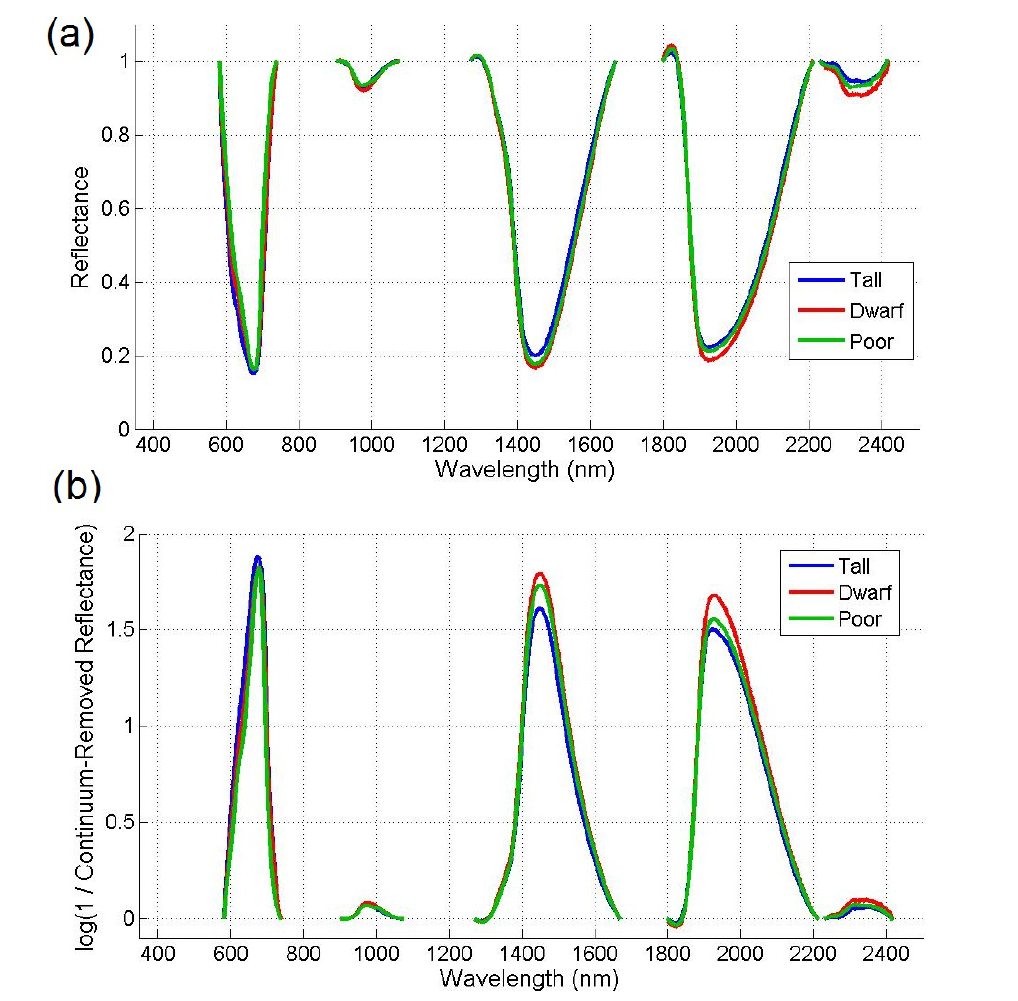
Figure 4. Continuum removed ( a ) mean canopy reflectance spectra for Avicennia germinans of three conditions (Tall: n = 30; Dwarf: n = 30; Poor: n = 30); ( b ) log